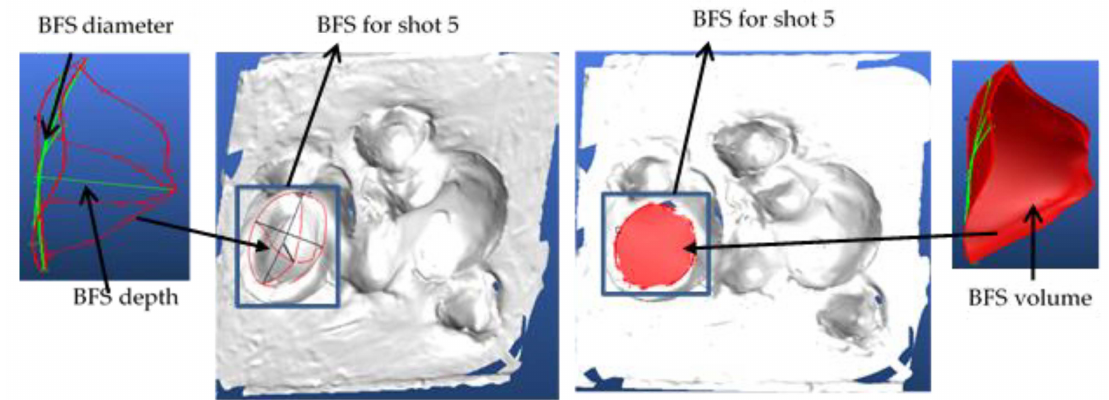
Figure 8. Modeling of the back face signature (BFS) using 3D modeling software and measuring its different values for shot 5.